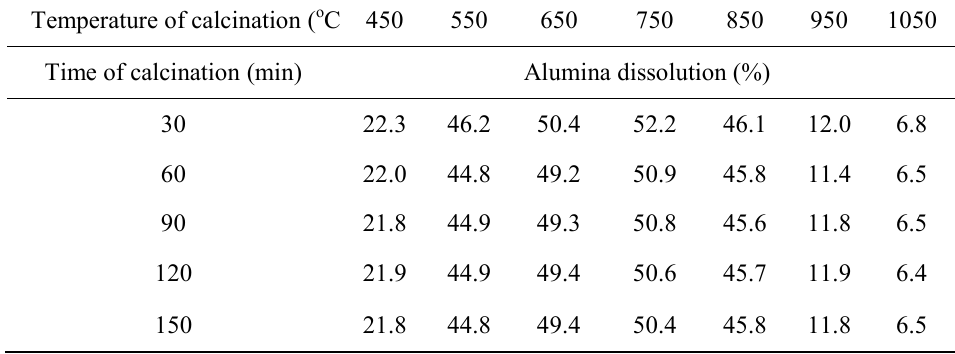
Table 1 . Effect of calcinations temperature and duration of on alumina dissolution. Acid to clay ratio: 40 wt%; concentration: 2M sulfuric acid; extraction temperature: 80 o C; extraction duration: 30